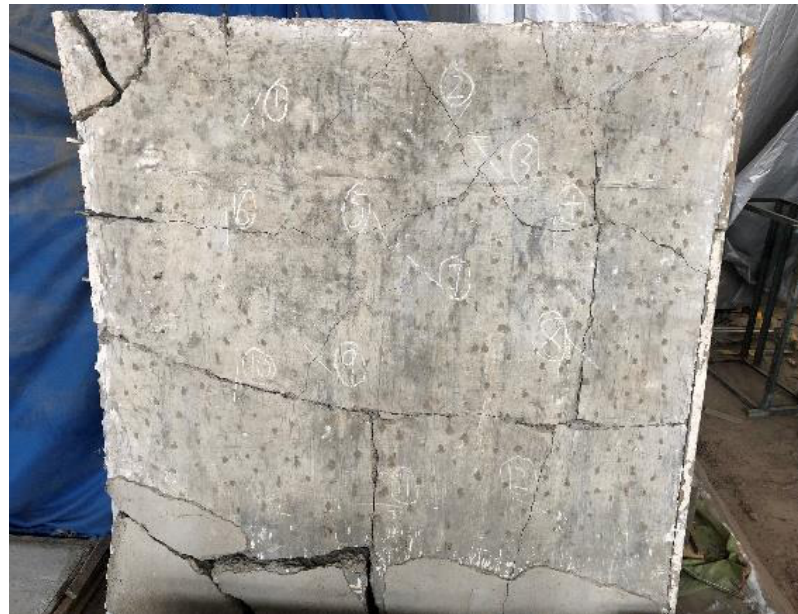
Figure 19. Concrete wall with 12 naturally occurring cracks.